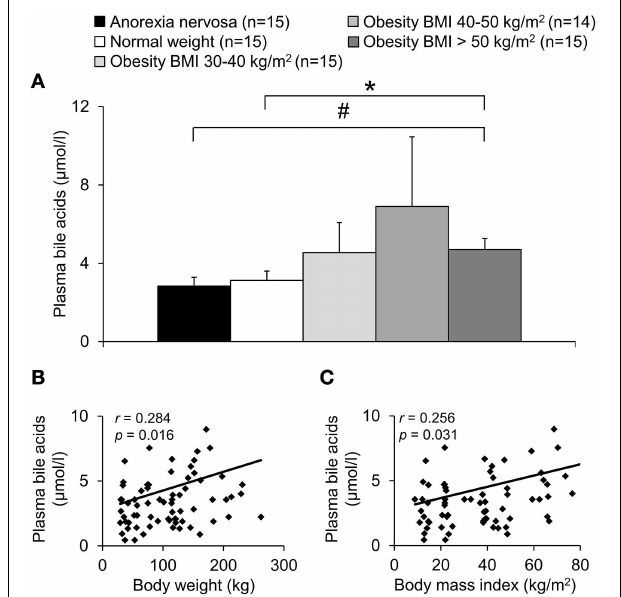
FIGURE 1 | Plasma bile acids show a positive association with body weight. The study population was divided into five groups: underweight (anorexia nervosa), normal weight, and overweight (obese subjects with BMI between 30–40, 40–50, and > 50kg/m 2 ). The plasma concentration of bile acids shows an increase with BMI reaching significance in the obese group with BMI > 50kg/m 2 compared to the anorexic and normal weight group (A) . A positive correlation is observed between plasma bile acids and body weight (B) as well as BMI (C) . Values for r and p are indicated in the correlation graphs. Data in (A) are expressed as mean ± sem of n = 14 –15 subjects/group. * p < 0 . 05 vs. normal weight and # p < 0 . 05 vs. anorexia